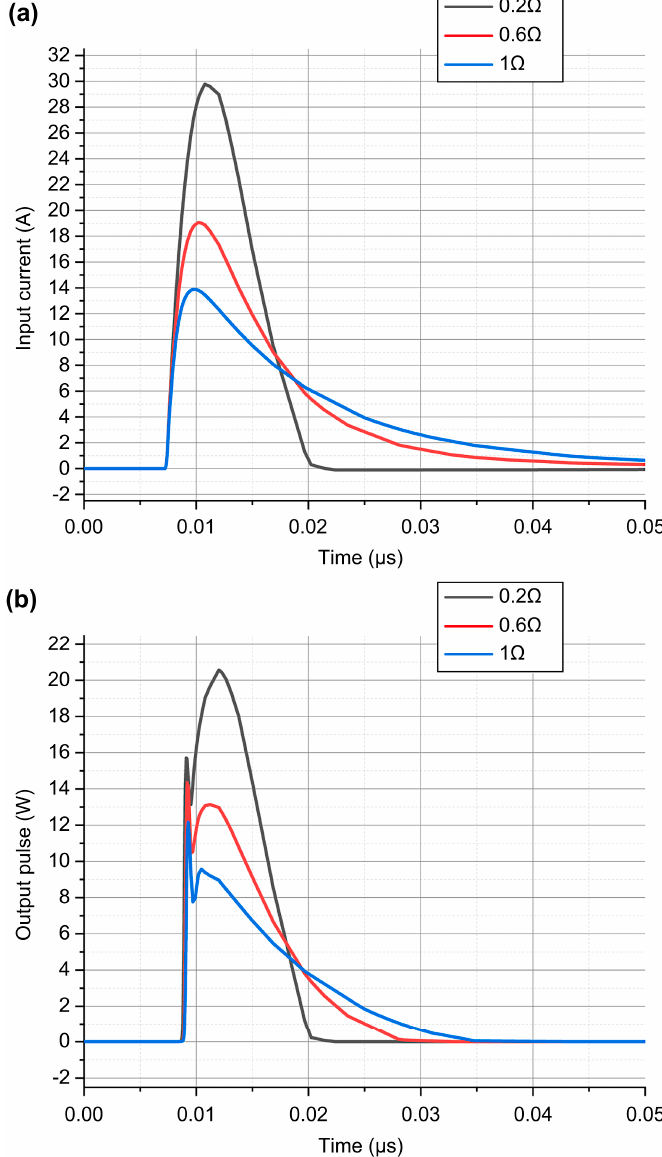
Figure 9. ( a ) Laser-input current and ( b ) output pulse waveforms for different package parasitic resistances.